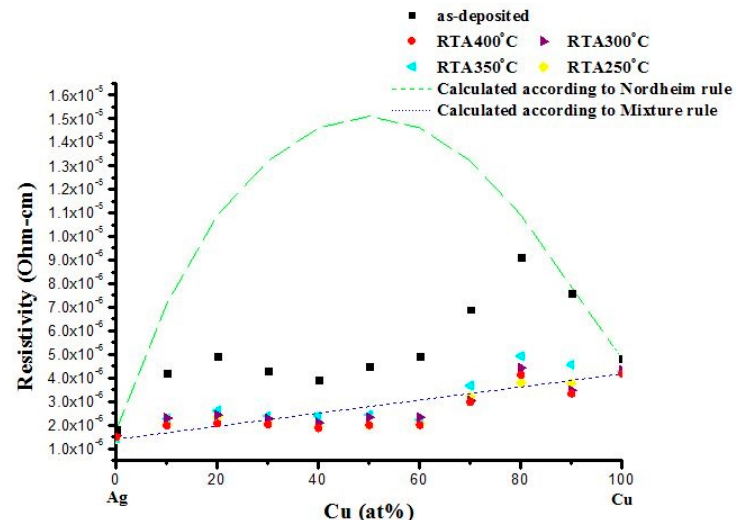
Figure 6. Electrical resistivity of Cu–Ag alloy films, before and after annealing. The calculated resistivity according to Nordheim’s rule and mixture rule are plotted as references.